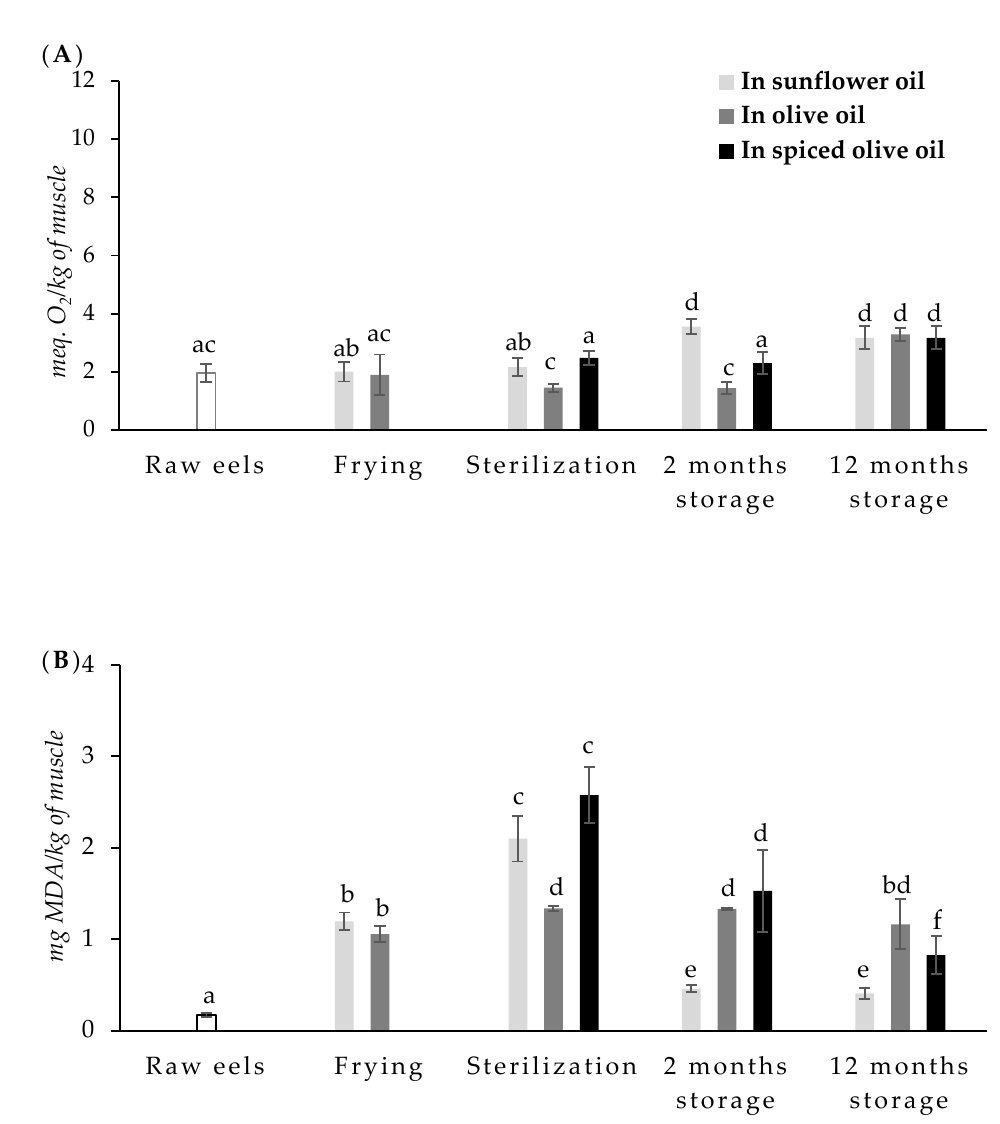
Figure 2. Peroxide values (PVs) (meq. O 2 /kg of the sample) ( A ) and thiobarbituric acid reactive substances (TBARS) values (mg malonaldehyde/kg of the sample) ( B ) of raw and canned European eel in each step during the canning process and at 2 and 12 months of stored. a–f Mean values with different letters are significantly different ( p < 0.05).